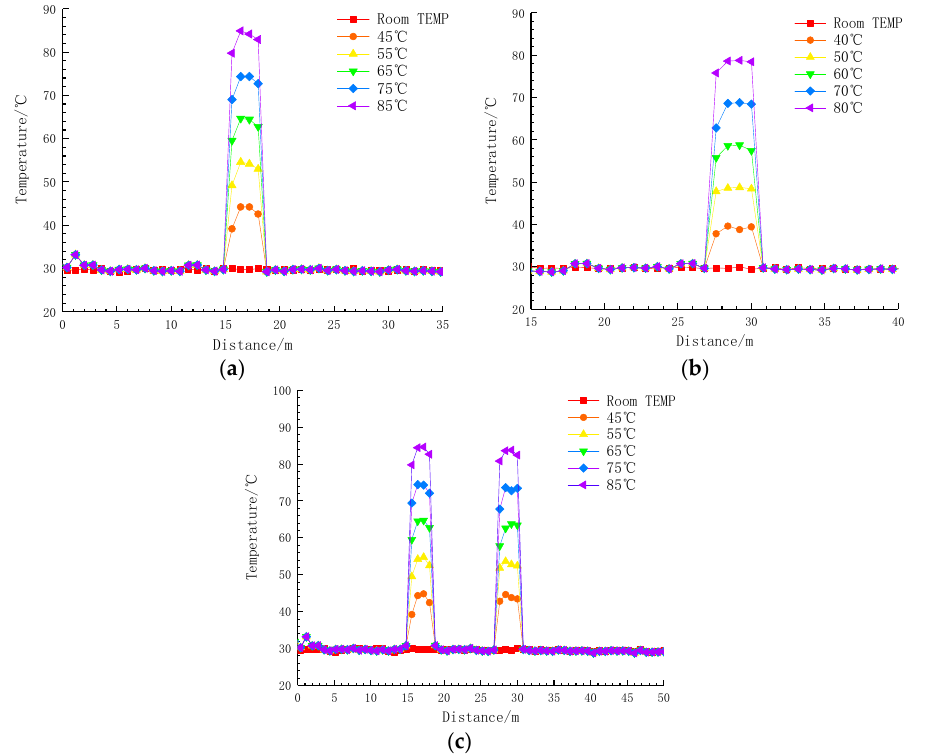
Figure 14. ( a ) The 8th cake heating up; ( b ) the 13th cake heating up and ( c ) the 8th and 13th cakes heating up.